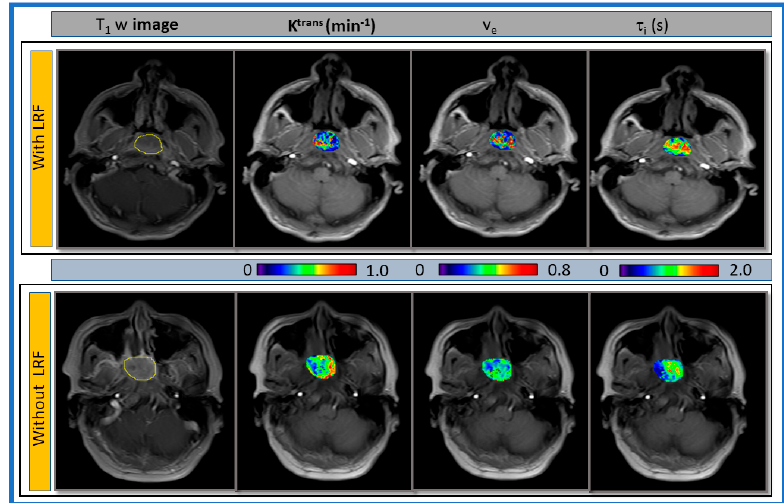
Figure 5. Representative pre-treatment (TX) T 1 w images from a late phase dynamic series from patients with (67-year-old female) and without locoregional failure (LRF) (55-year-old male) of nasopharyngeal cancer. Primary tumor parametric maps of volume transfer constant (K trans ), extravascular extracellular space volume fraction (v e ), and mean lifetime of intracellular water protons ( τ i ) overlaid on pre-TX T 1 w images.